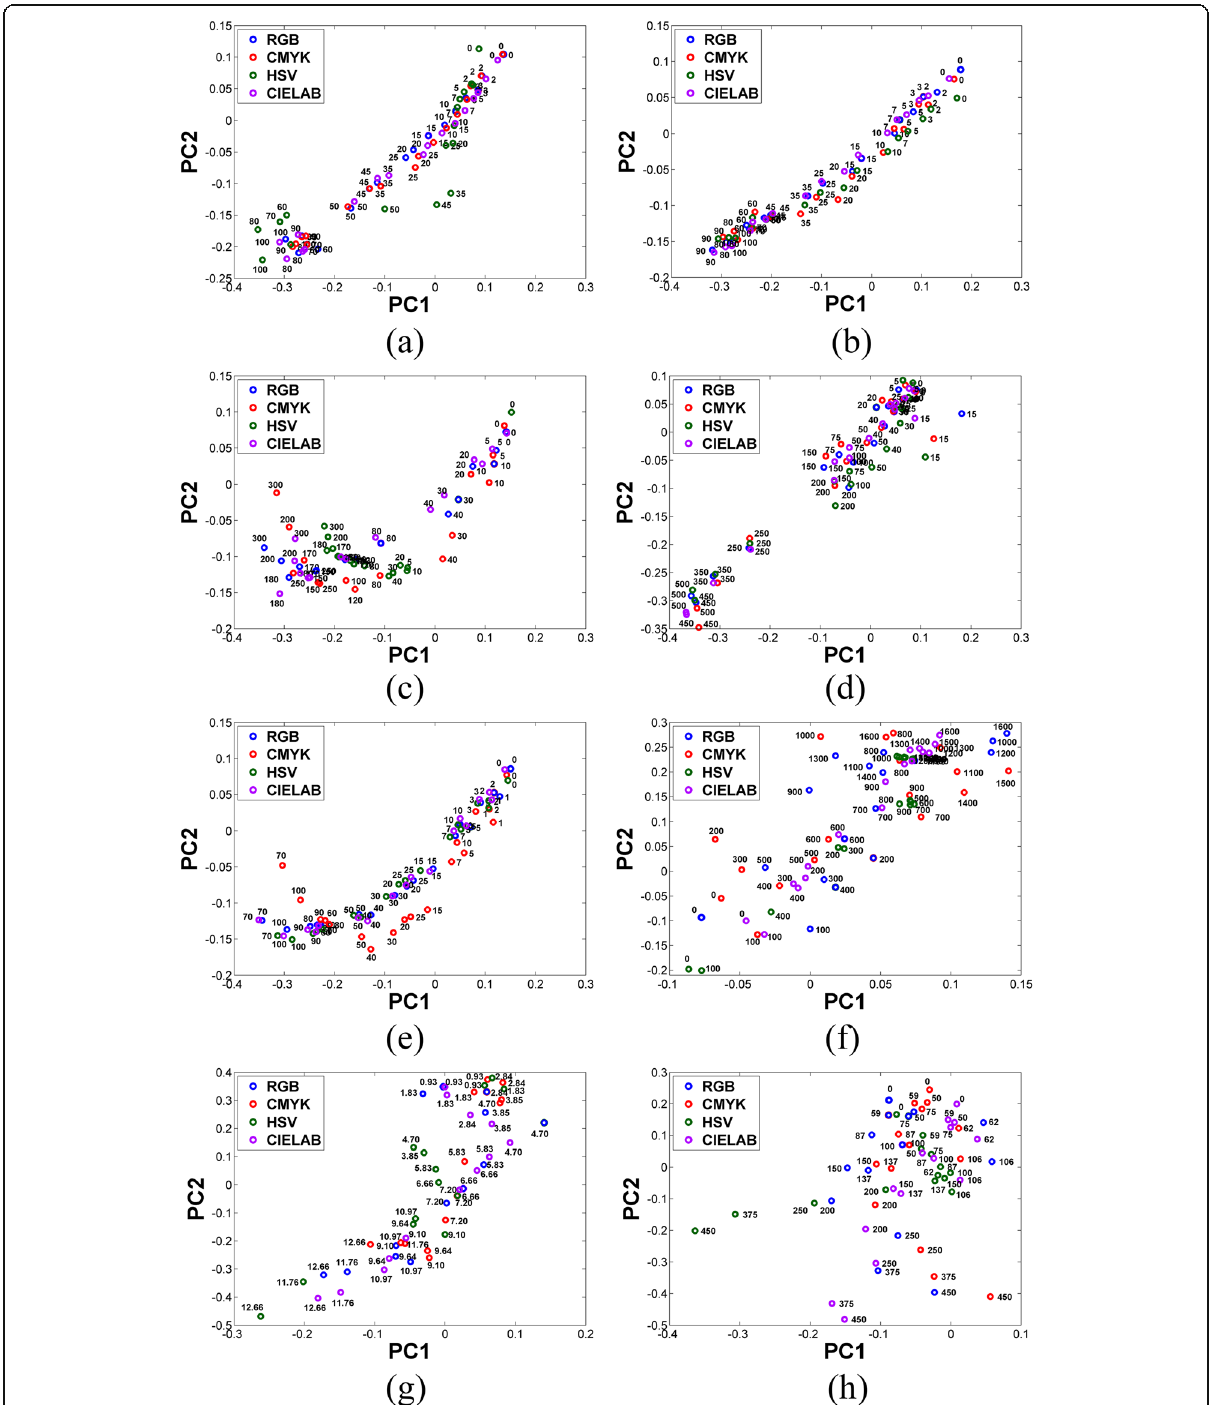
Fig. 4 Procrustes PCA score plots of a Mn 2+ , b Fe 2+ /Fe 3+ , c Cu 2+ , d NO 3 - , e PO 4 3- , f SO 4 2- , g pH, and h total hardness test